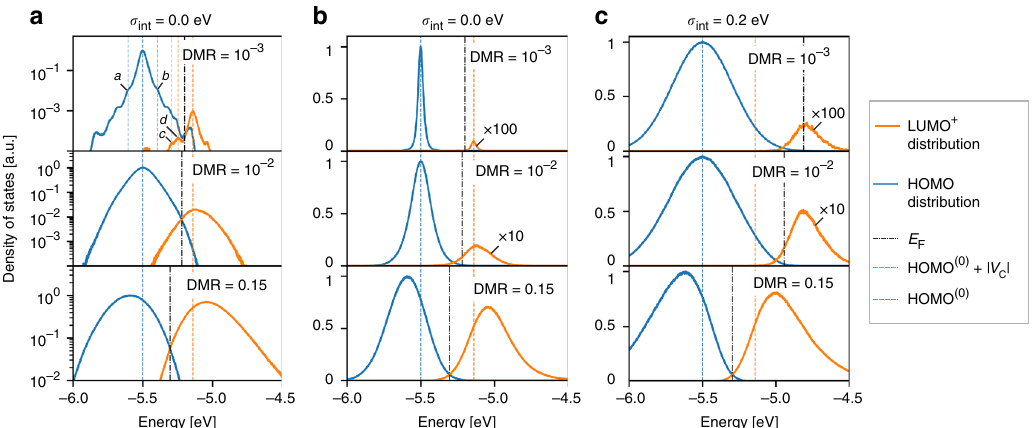
ffiffiffi p 2 to dopant anions (host ffiffiffi p ffiffiffi p 3 and a = 2 to dopant anions, respectively. At low and moderate DMR (top